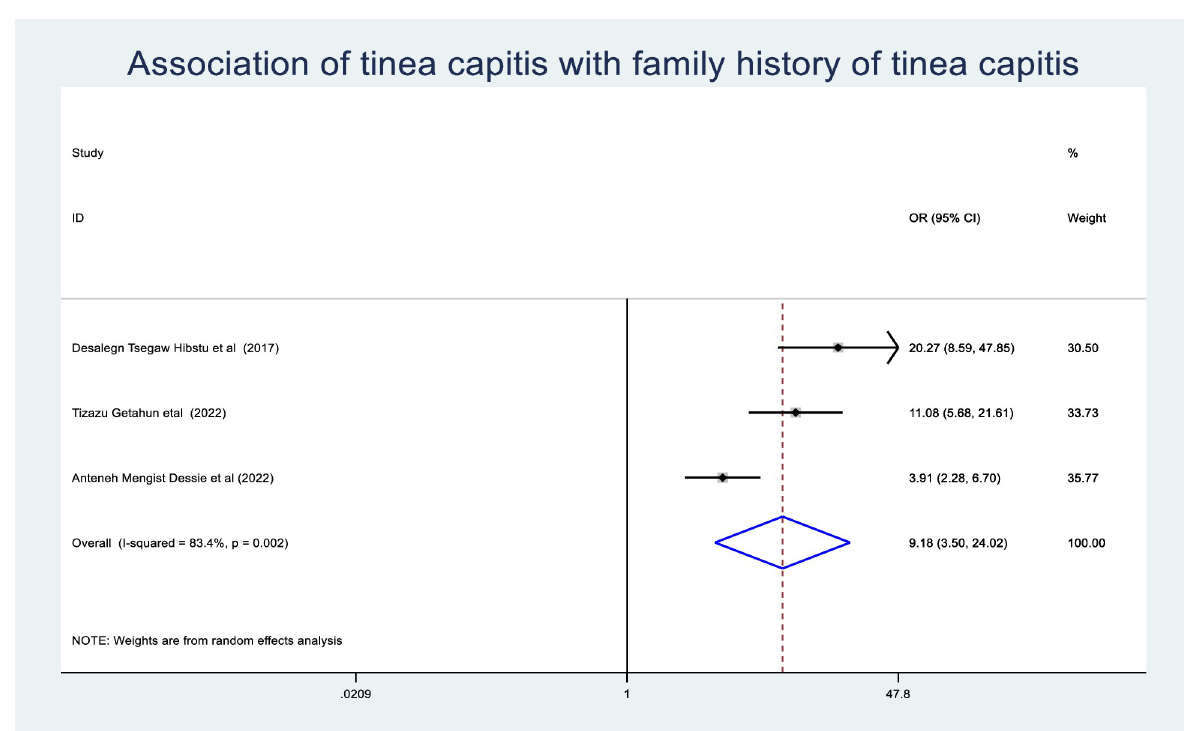
Fig 11. Association of tinea capitis with family history of schoolchildren.